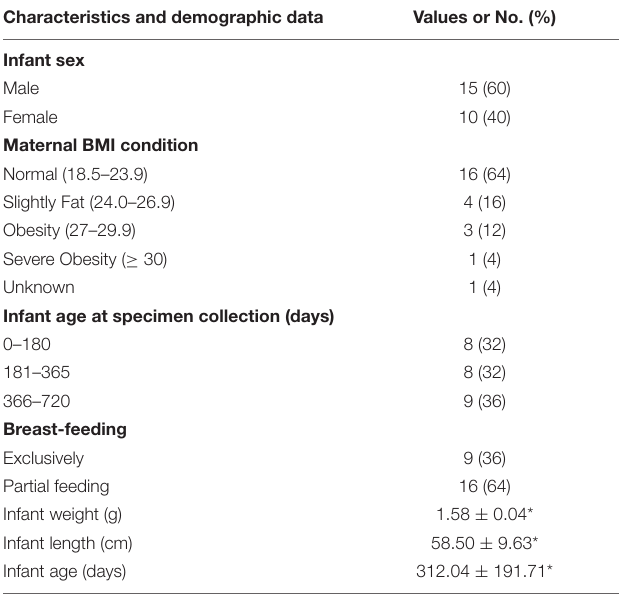
TABLE 1 | Clinical and demographic characteristics of the mothers and infants in the study population. Characteristics and demographic